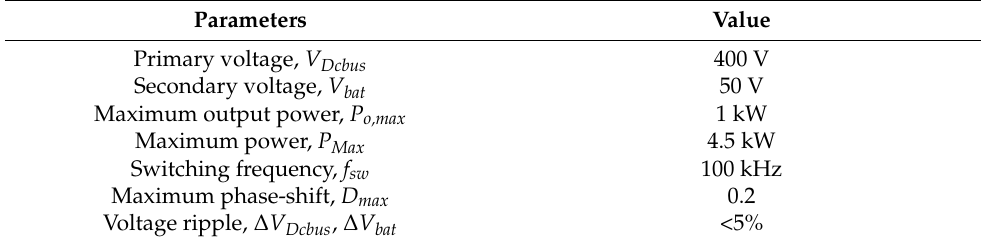
Table 2. Design parameters of the DAB converter prototype. Parameters Value Primary voltage, V